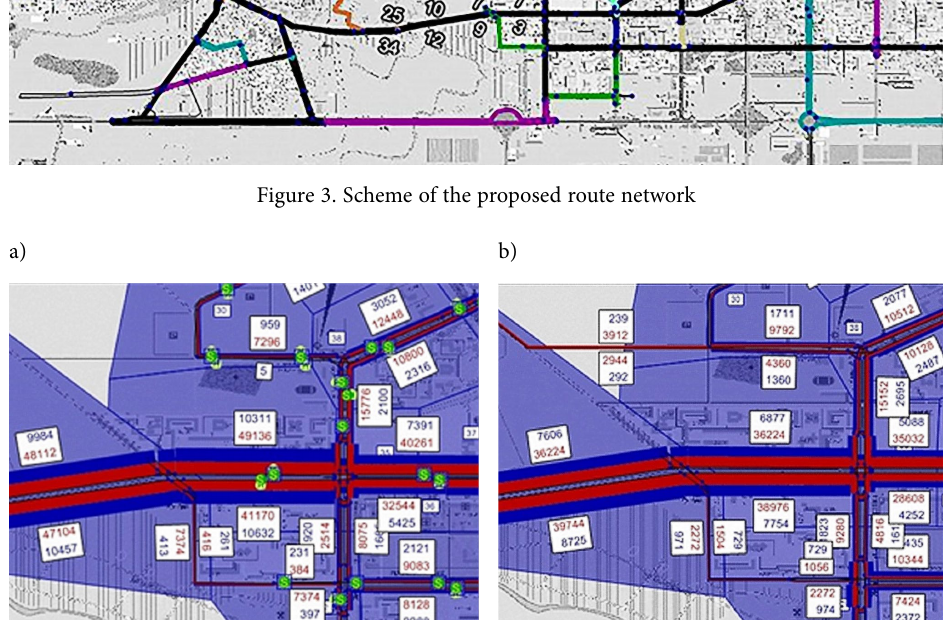
Figure 4. Distribution of transport load according to: a – existing passenger flow and route